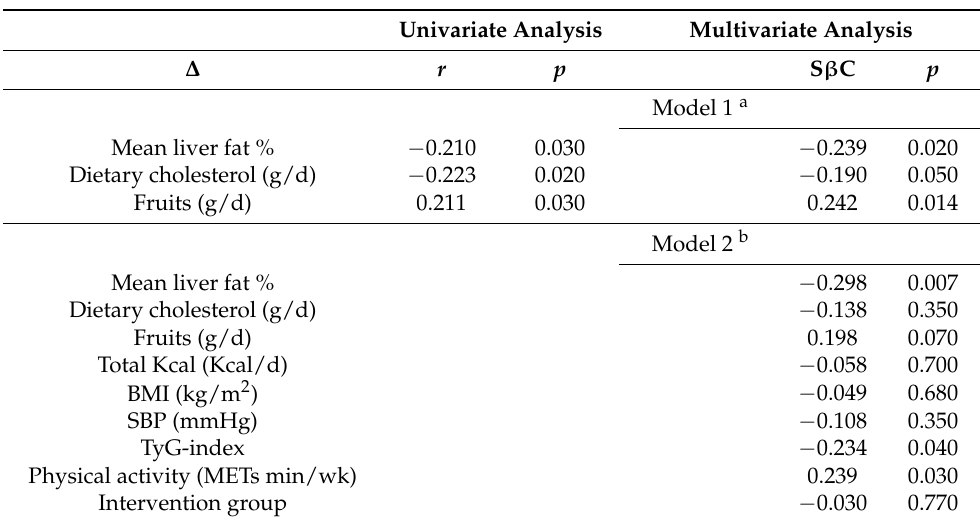
Table 7. Univariate and multivariate analyses of the association between change (delta) in eGFR (mL/min) and changes (delta) in possible covariates between baseline and 6 months for the whole sample ( n =